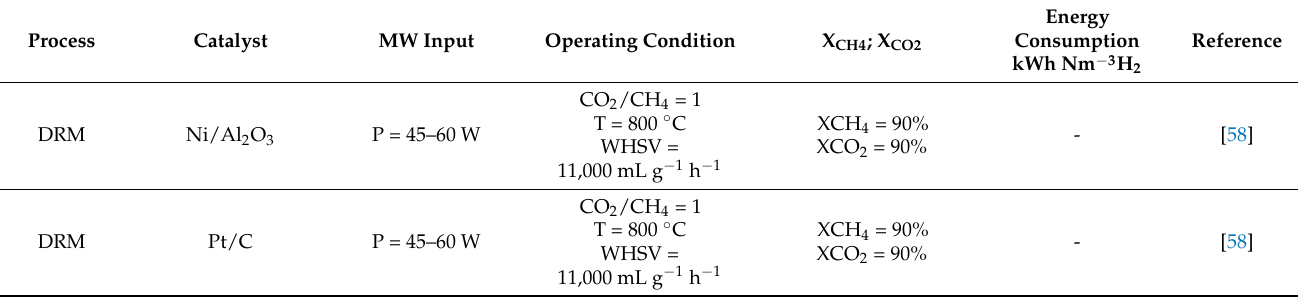
Table 2. Summary of the performance of the most recent developed catalysts in MW-assisted reforming